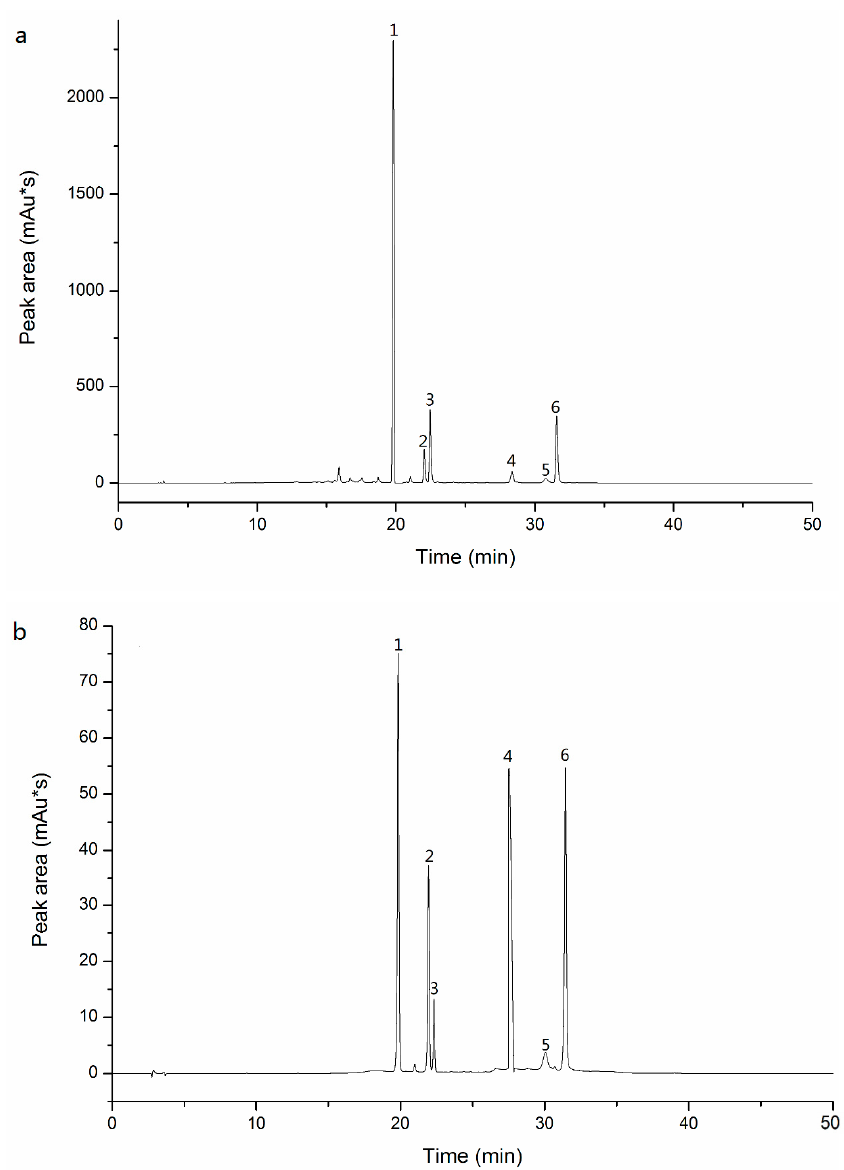
Figure9. TheHPLCchromatogramsofFSIsamples( a )andstandardsmixture( b )detectedatwavelength 360 nm. 1: RU; 2: NI; 3: NA; 4: KA; 5: IS; and 6: Figure 9. The HPLC chromatograms of FSI samples ( a ) and standards mixture ( b ) detected at wavelength 360 nm. 1: RU; 2: NI; 3: NA; 4: KA; 5: IS; and 6: QU. 3.6. Sample Preparation Based on UAE